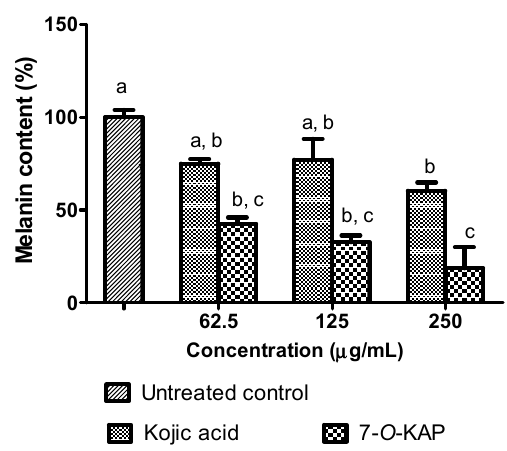
KAP, respectively.